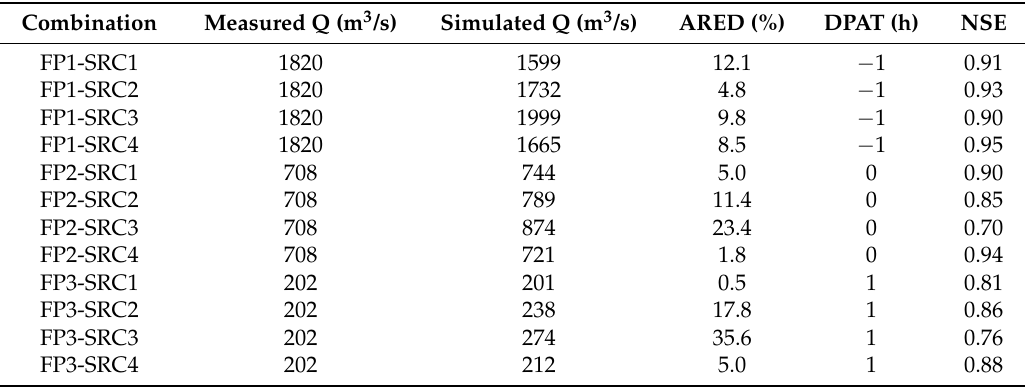
Table 3. The statistical analysis of the measured and simulated discharge (Q).